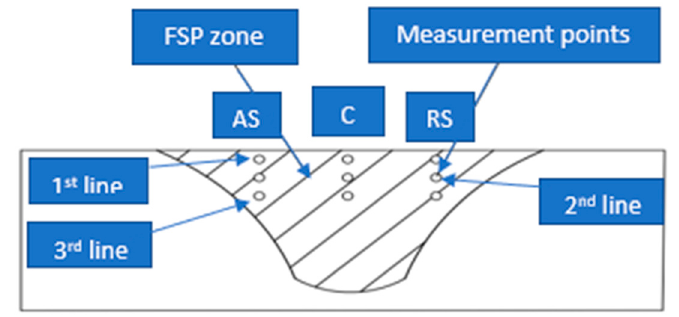
Figure 4. Microhardness measurement points in the stir zone (SZ).